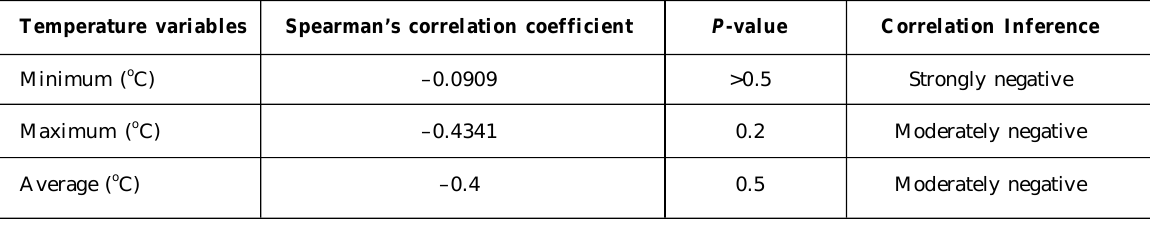
Table 1: Relationship between COVID-19 incidences and temperature variables